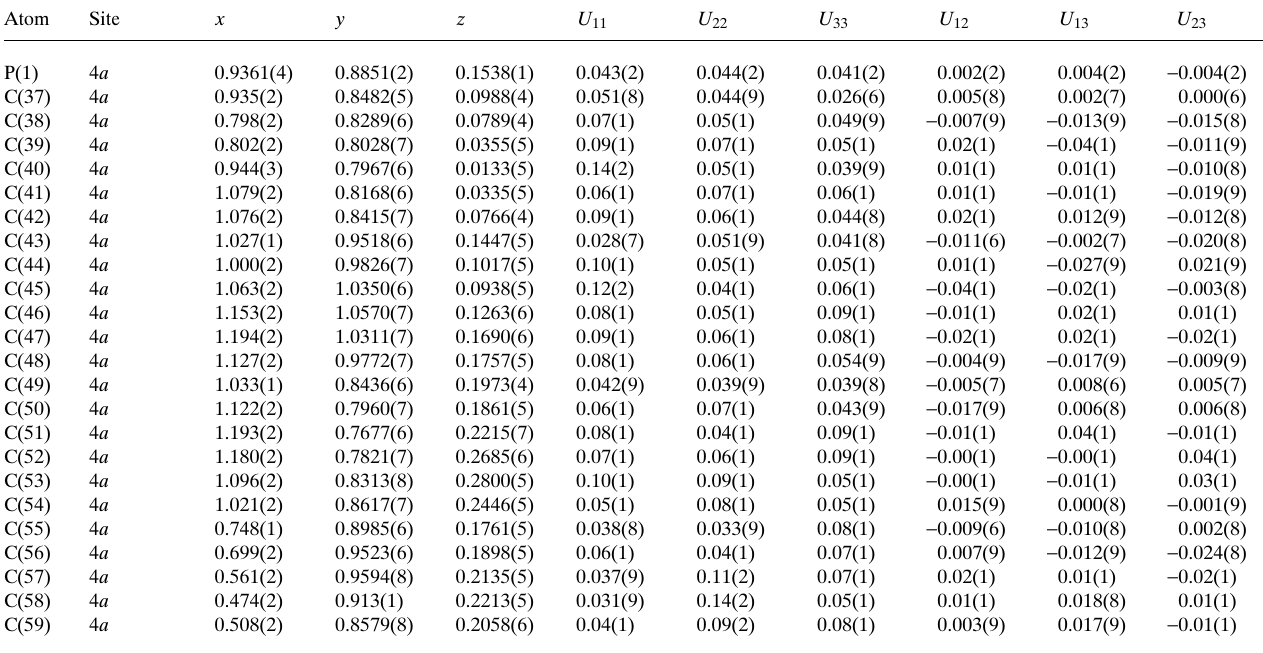
Table 3. Atomic coordinates and displacement parameters (in Å 2 ) .